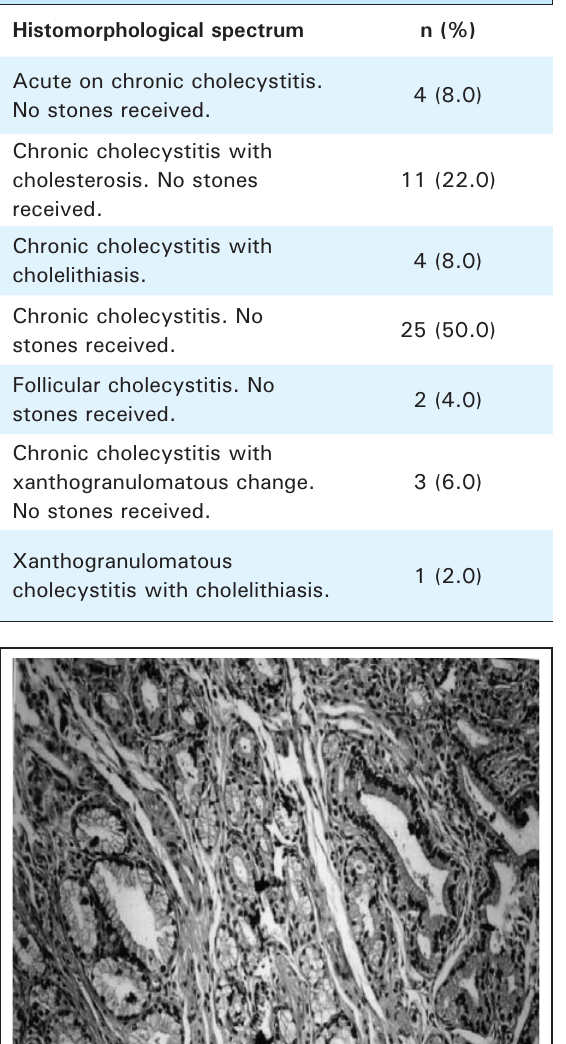
Table 2. Histomorphological spectrum. Histomorphological spectrum